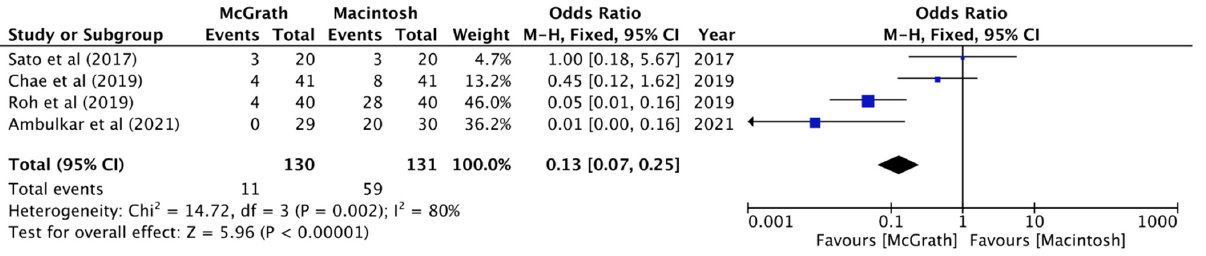
Figure 5. Forest plot of the Magill forceps used (McGrath vs. Macintosh laryngoscope).